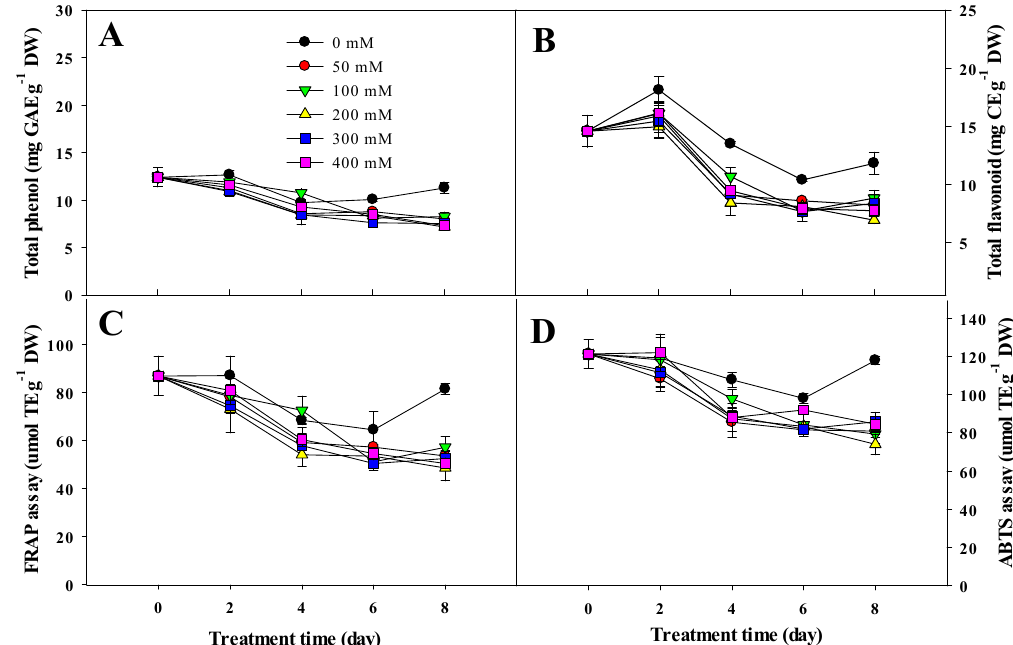
Figure 4. Effect of different NaCl concentrations on total phenol content ( A ), total flavonoid content ( B ), FRAP assay ( C ) and ABTS assay ( D ) in lettuce seedlings during treatment. Each plot point represents mean ± SD of three replicates. FRAP: ferric reducing antioxidant power; ABTS: 2,2 ′ -azino-bis (3-ethylbenzothiazoline-6-sulfonic acid).